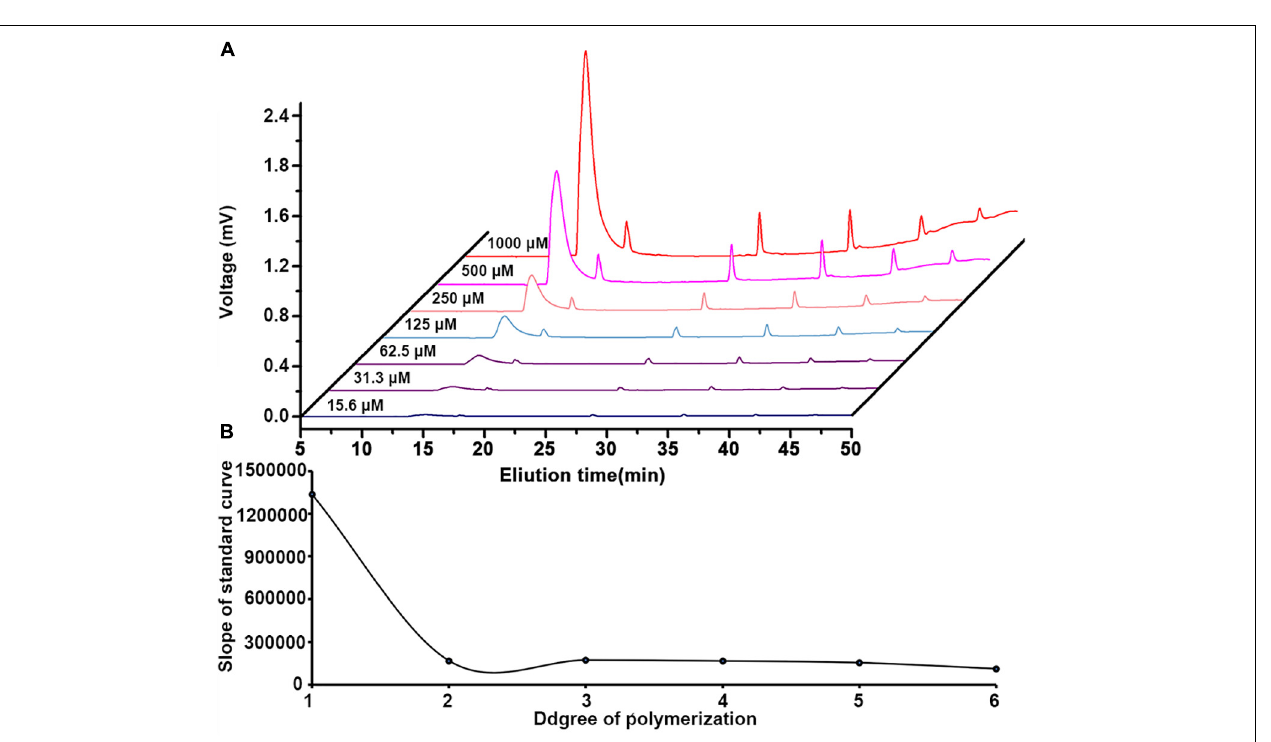
Frontiers in Nutrition |